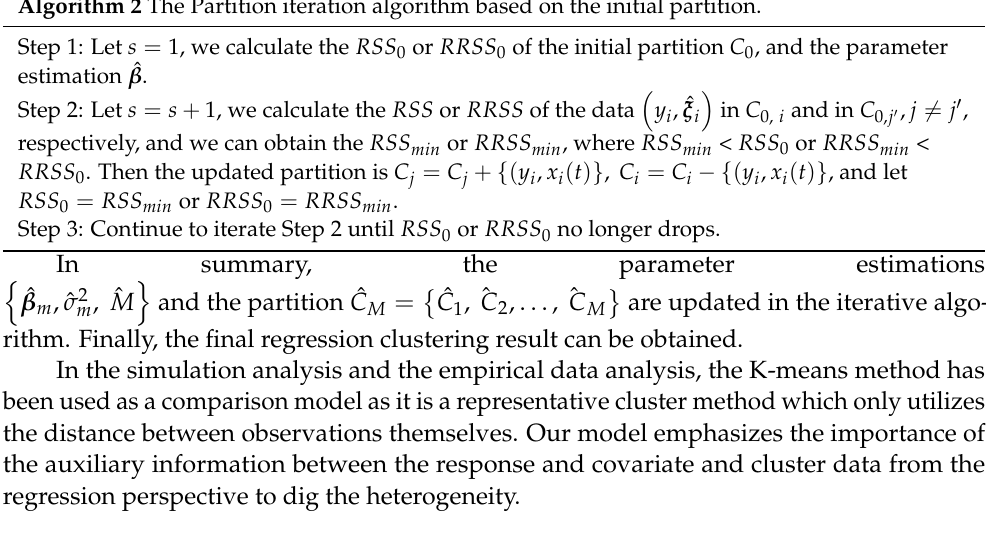
Algorithm 2 The Partition iteration algorithm based on the initial